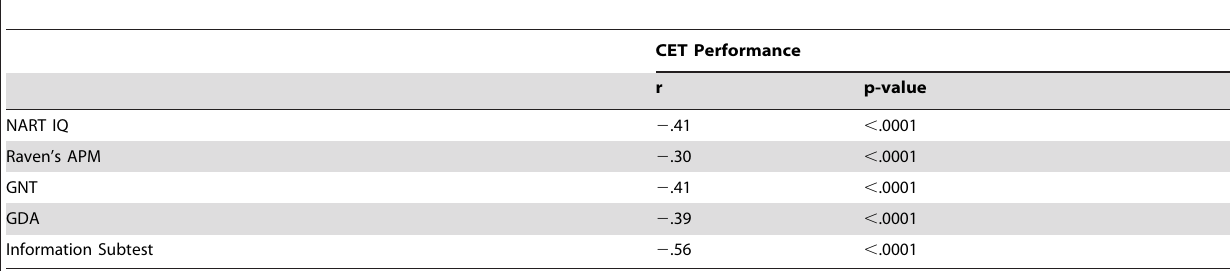
Table 3. Correlational analyses between CET performance and the background neuropsychological